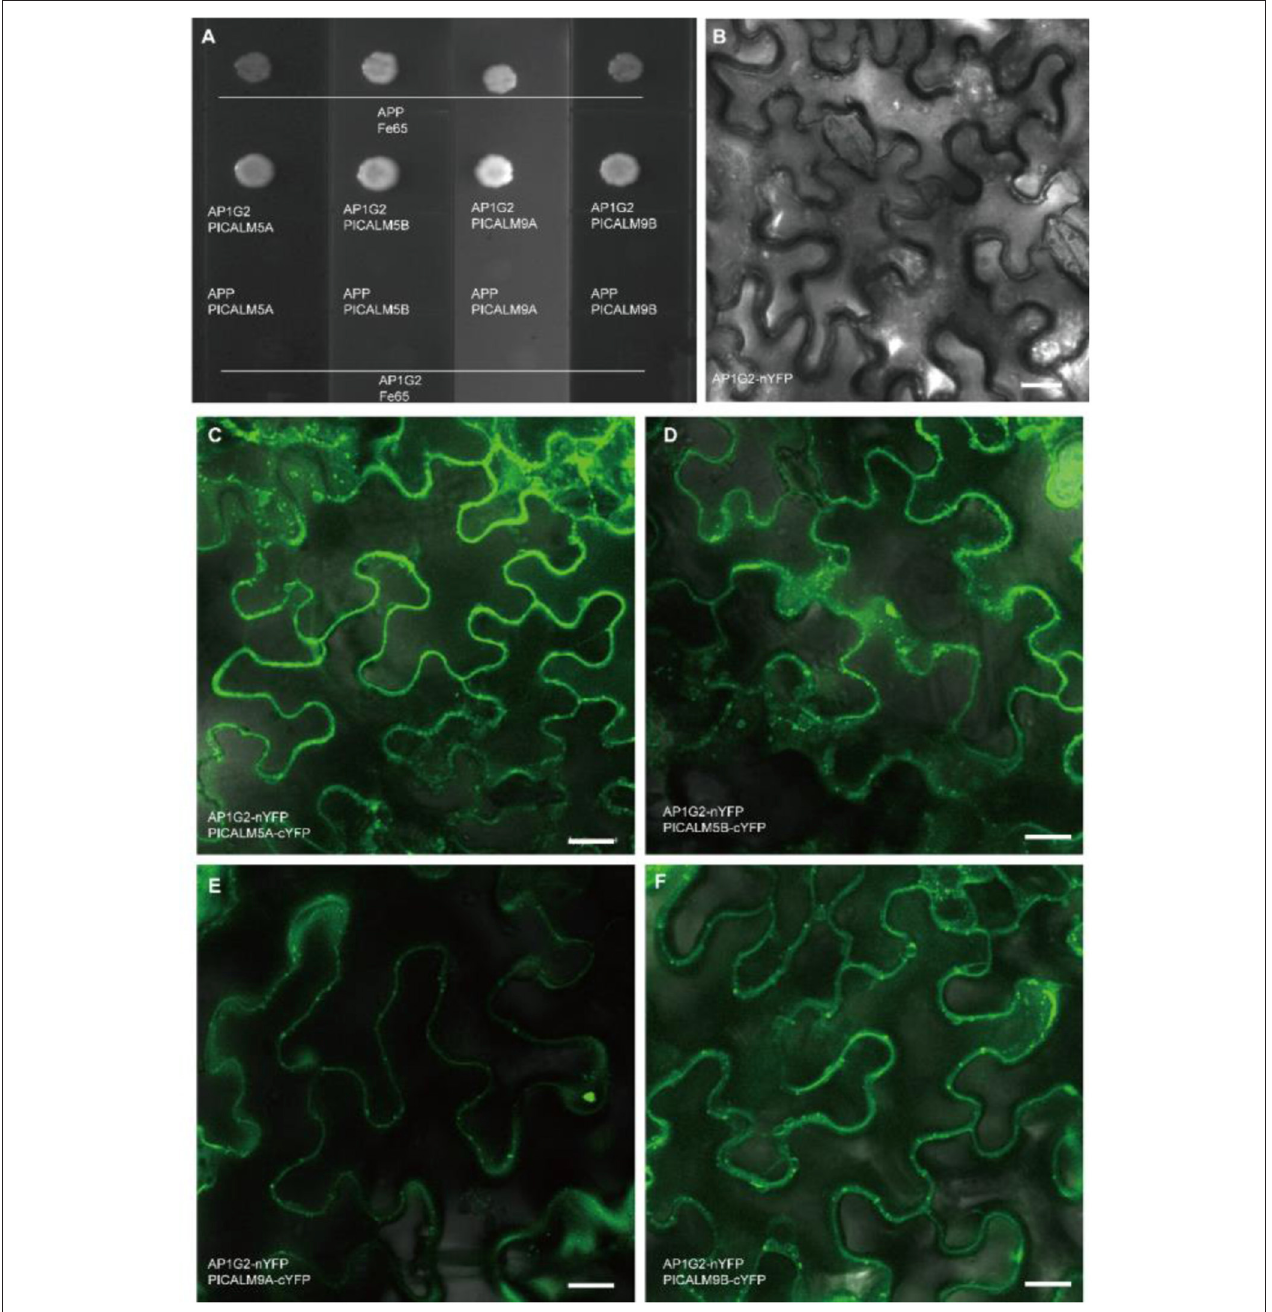
FIGURE 8 | (A) The protein-protein interactions of AP1G2 and PICALM5A/B and PICALM9A/B in yeast. Vectors pTSU2-APP and pNubG-Fe65 were positive control bait and prey, respectively. (B–F) BiFC analysis of AP1G2 and PICALM6A/B and PICALM9A/B in tobacco leaf epidermis. (B) is a negative control. Confocal images showing YFP fluorescence indicated